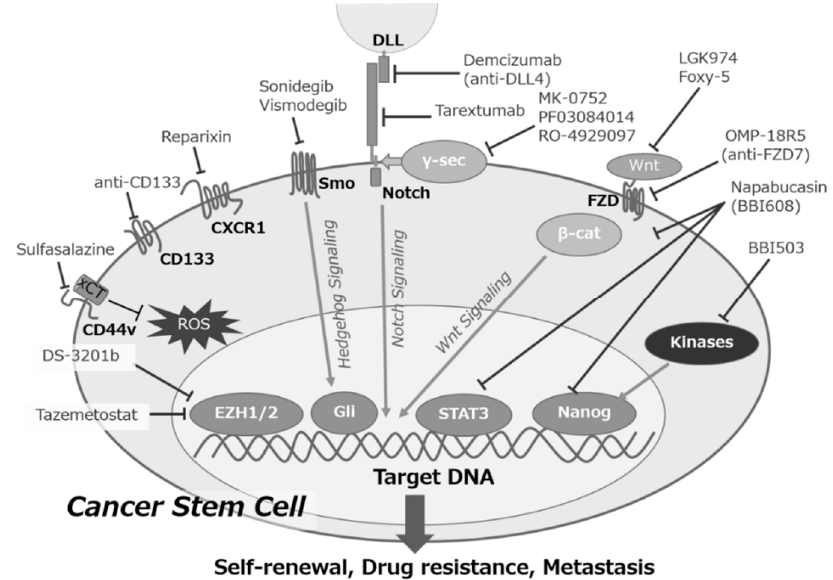
Figure 2. Aberrant signal transduction pathways in CSCs and therapeutic agents targeting CSCs.